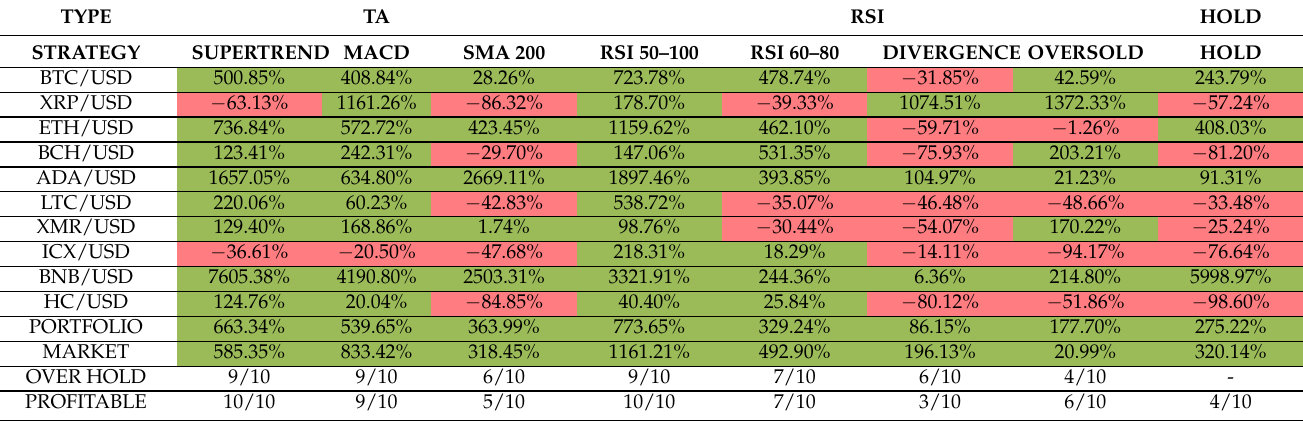
Table 9. The results of strategies from experiments compared to popular trading strategies and strategy proposed by authors between 2018 and 2022. Green indicates positive results, red indicates negative